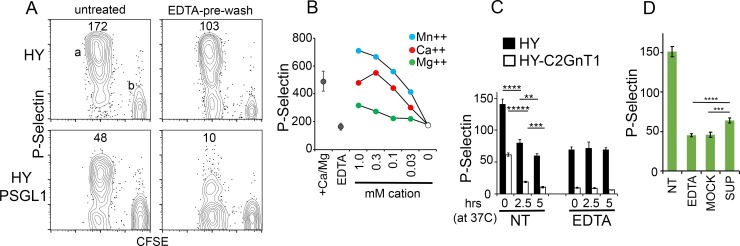
PSL2 association with activated T cells requires Ca++.(A) Cation removal eliminates expression of PSL2. P-selectin staining of ex-vivo CD8+ CFSE-labeled HY or HY-PSGL1null donor T cells responding (CFSElow cloud ‘a’) and non-responding (CFSEhigh cloud ‘b’) at day 3 in PSGL1null recipients (left panels). In right panels, aliquots of the same cells were washed twice in EDTA-containing media, returned to Ca++ replete media, and then stained with P-selectin. Geometric mean values for P-selectin staining of responding (CFSE diluted) donor cells are shown. Fig 2A is representative of five independent analyses. (B) Cation specificity to support PSL2 expression. OT1-C2GnT1null cells responding to Ovalbumin in PSGL1nullThy1.1 recipients were recovered at day 3. The cation-specific dependence of PSL2 expression on these cells was assessed after 5x serial washing in media containing the indicated concentrations of Mn++, Ca++, or Mg++ divalent cations, and returned to Ca++/Mg++ replete media, prior to P-selectin staining. Positive control, (+Ca/Mg), P-selectin staining of responding cells maintained in Ca++/Mg++ replete media. Negative control (EDTA) P-selectin staining of responding cells pre-washed with EDTA-media. Standard deviation of triplicate control stains shown. Fig 2B is representative of four independent analyses. (C) Persistence of PSGL1 P-selectin ligand and loss of PSL2 P-selectin ligand with in vitro culture. HY and HY-C2GnT1null donor cells responding in independent male PSGL1null recipients were harvested on day 3 and either untreated (NT), or pre-washed with EDTA-containing media (PSL2 stripped) and then transferred into Ca++/Mg++ replete media (EDTA). Cells in NT or EDTA groups were then held on ice (0), or cultured at 37°C for 2.5 or 5 hours prior to P-selectin staining. Mean and standard deviation of three P-selectin staining replicates for each condition is shown. P-values determined by two-tailed Student’s T-tests with equal variance; **** P value = 0.0005, ***** P value = 0.00001, *** P value = 0.001, ** P value = 0.008. Fig 2C is representative of three independent analyses. (D) PSL2 rebinding. CD8+
HY-C2GnT1null donor T cells were recovered from peripheral lymph nodes of male PSGL1null
Thy1.1 recipients on day 3 and semi-purified (to >50% purity). Responding donor derived cells were either stained for P-selectin (NT) or treated with EDTA-pre-wash to generate donor cells lacking PSL2 (EDTA) and a supernate extract. The supernate extract was made Ca++ replete and compared with a mock supernate, prepared identically except never exposed to cells, for their respective capacity to restore P-selectin ligand expression (SUP vs MOCK) on responding, EDTA pre-washed, donor-derived T cells. Mean and standard deviation of three P-selectin staining replicates for each condition is shown along with P-values determined by two-tailed Student’s T-test. **** P value = 0.00073, *** P value = 0.0018. Fig 2D is representative of eight independent analyses.